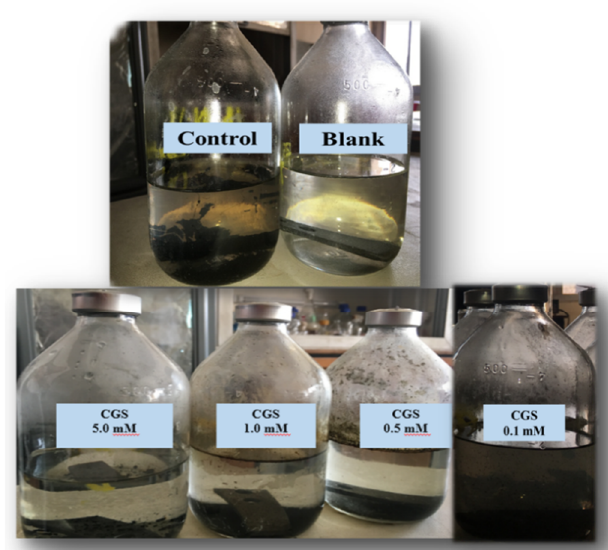
Figure 4. The application of the cationic gemini surfactant (SCGS) at different concentrations (0.1, 0.5, 1.0, 5.0 mM) in comparison to control reactor (inoculated with enriched environmental sulfidogenic bacteria at a salinity of 5.49% NaCl), and blank reactor (un-inoculated with enriched environmental sulfidogenic bacteria at a salinity of 5.49% NaCl).